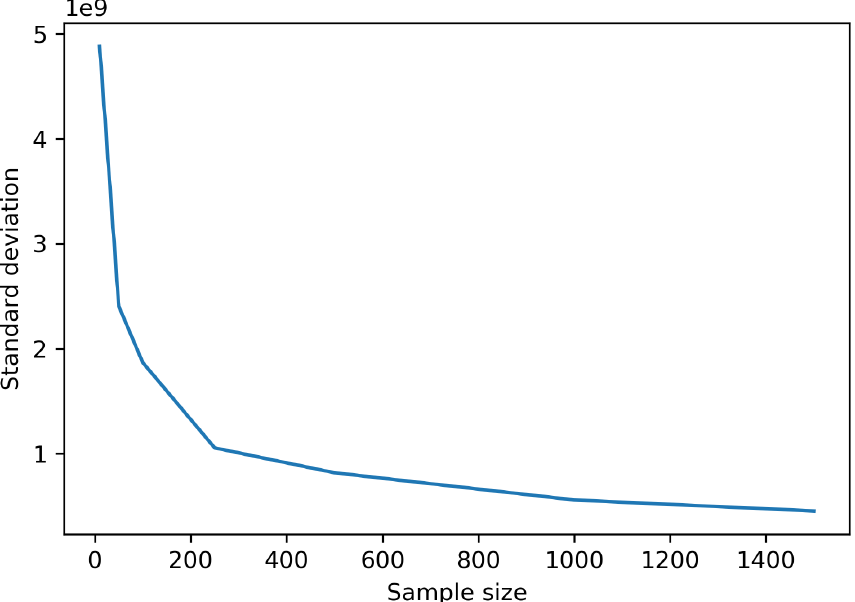
Figure B1. Spread in the standard deviations if the Monte Carlo simulation were to be repeated multiple times for a specific sample size, based on a bootstrapping